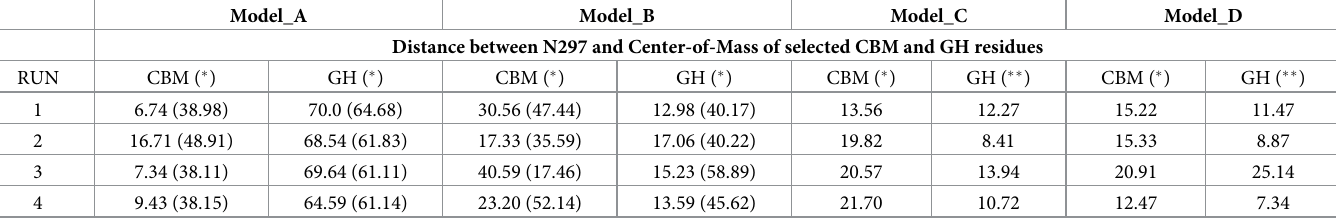
Table 2. Distance between N297 and the CBM or GH in the initial models. For model C the same N297 was used for both CBM and GH, while for model D the N297 from one chain was used for the CBM and the N297 from the second chain was used for the GH. N297 corresponds to the Fc glycosylation site. For models A and B, the values in parentheses correspond to the distance to the second N297. For model A, first glycan was selected based on the glycan interacting with CBM and for model B, first glycan was selected based on the glycan interacting with